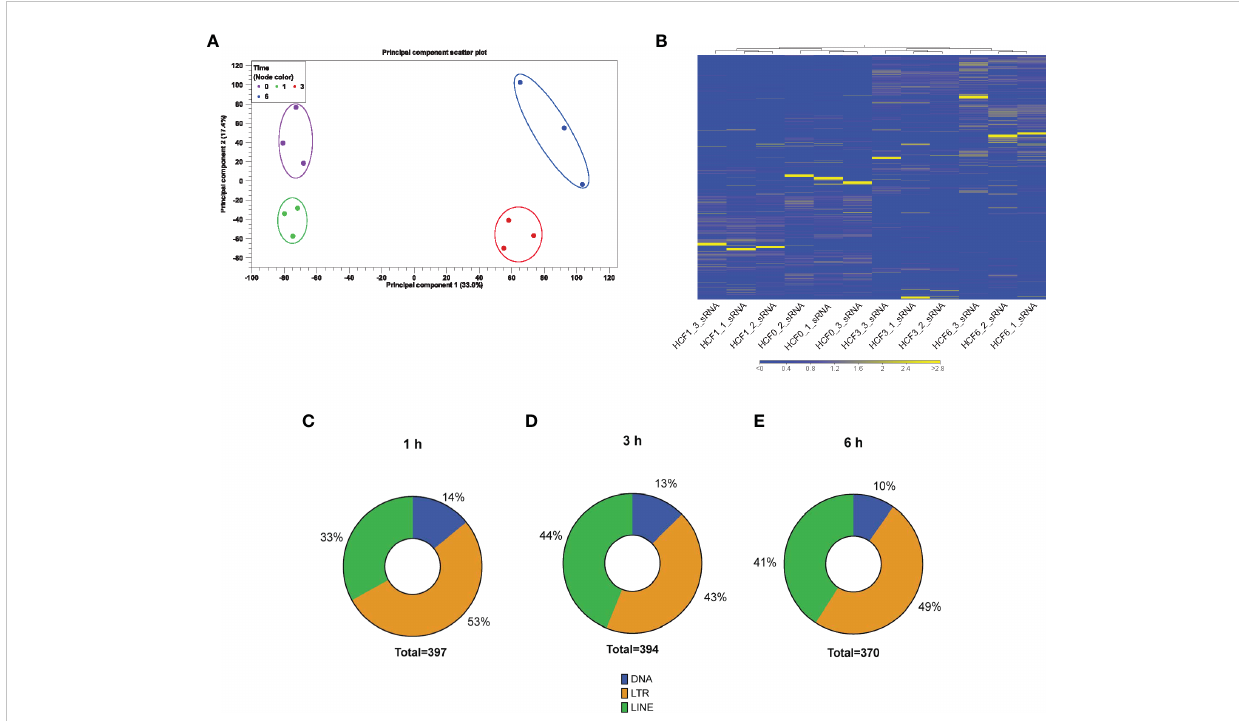
FIGURE 1 RNA-seq analysis of small RNAs dysregulated by T. cruzi infection of PHCF. (A) Principle component analysis of PHCF gene expression was completed for all samples and probe sets. The x-axis is PC1 while the y-axis is PC2, with the percentage of variance indicated in parenthesis. PHCF was challenged with T. cruzi for various time points (0, 1, 3, and 6) denoted by circle and clustering (0 h = purple, 1 h = green, 3 h = red, 6 h = blue). (B) Heatmap and hierarchical clustering was performed on control and test samples 0, 1, 3, and 6 h, respectively, using Euclidean distance measure and single linkage analysis. Each column represents one sample and each row represents one small non-coding RNA within the data set. (C – E) Differential expressed putative and known piRNAs induced during parasite challenge of PHCF at 1, 3, and 6 hours respectively, belong to various transposable element